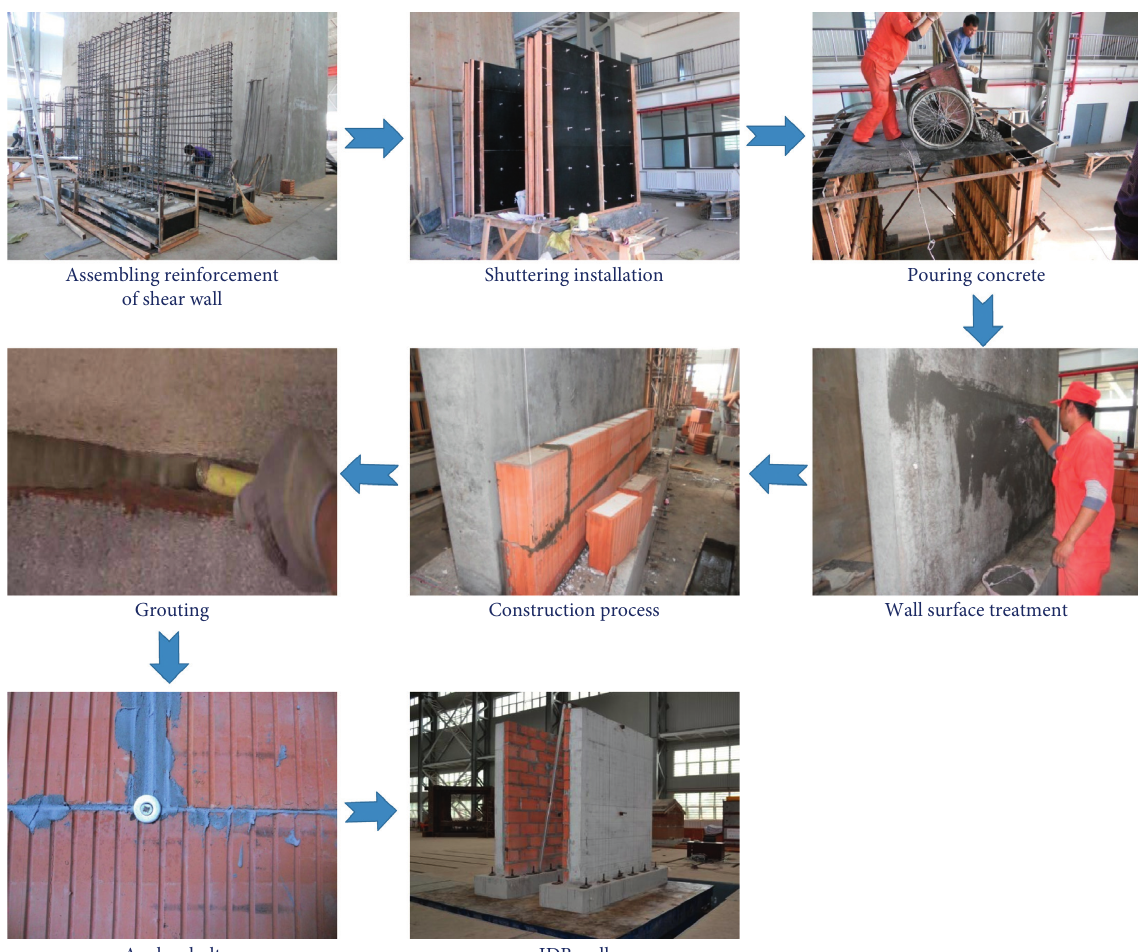
Figure 4: Construction process of specimens.